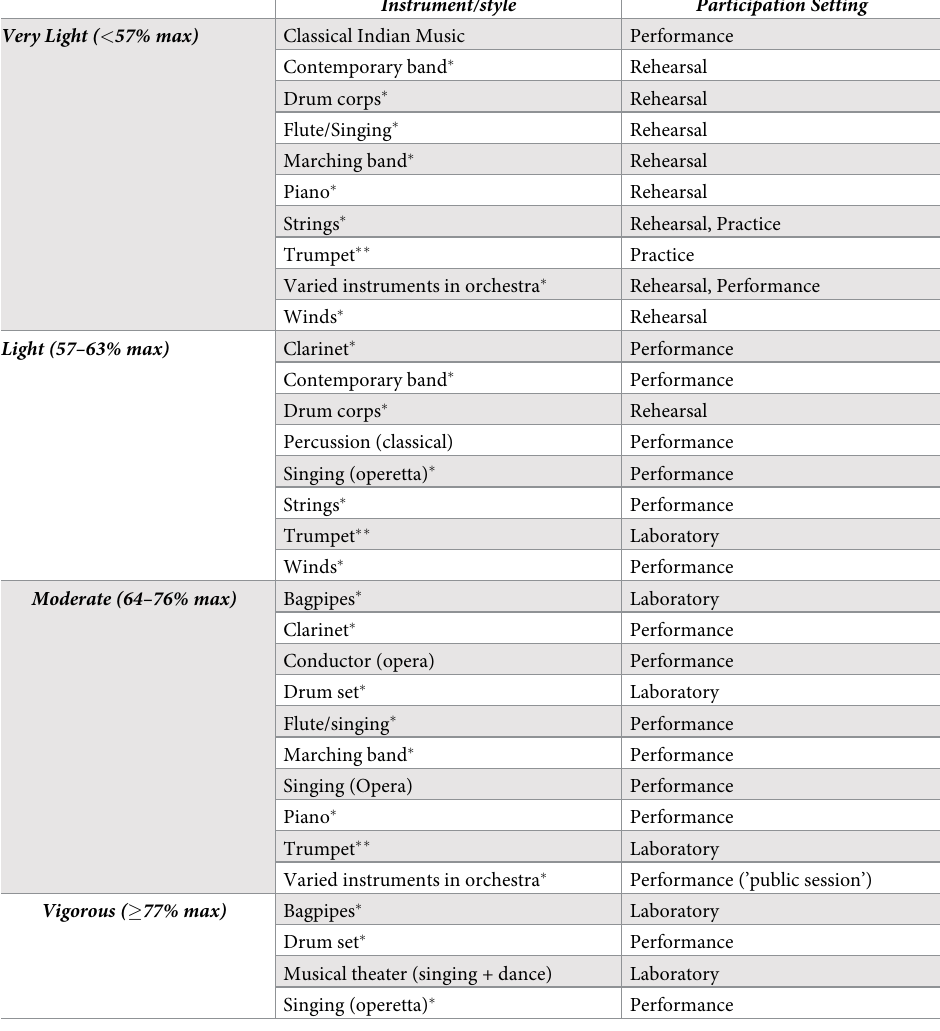
Table 3. Summary of heart rate responses to active music participation from included